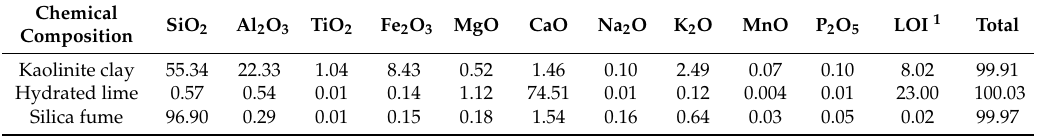
Table 1. Oxide compositions of used materials (wt